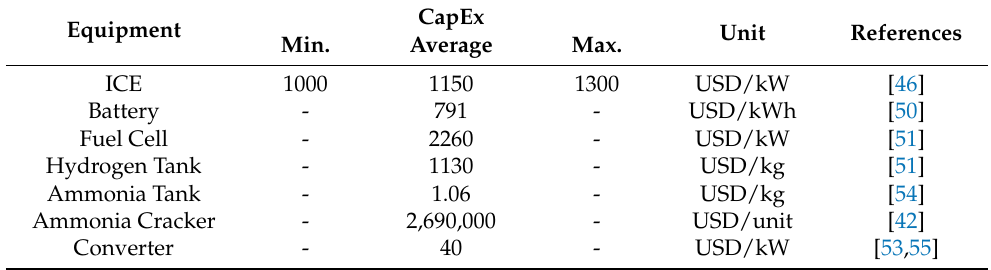
Table 5. List of capital